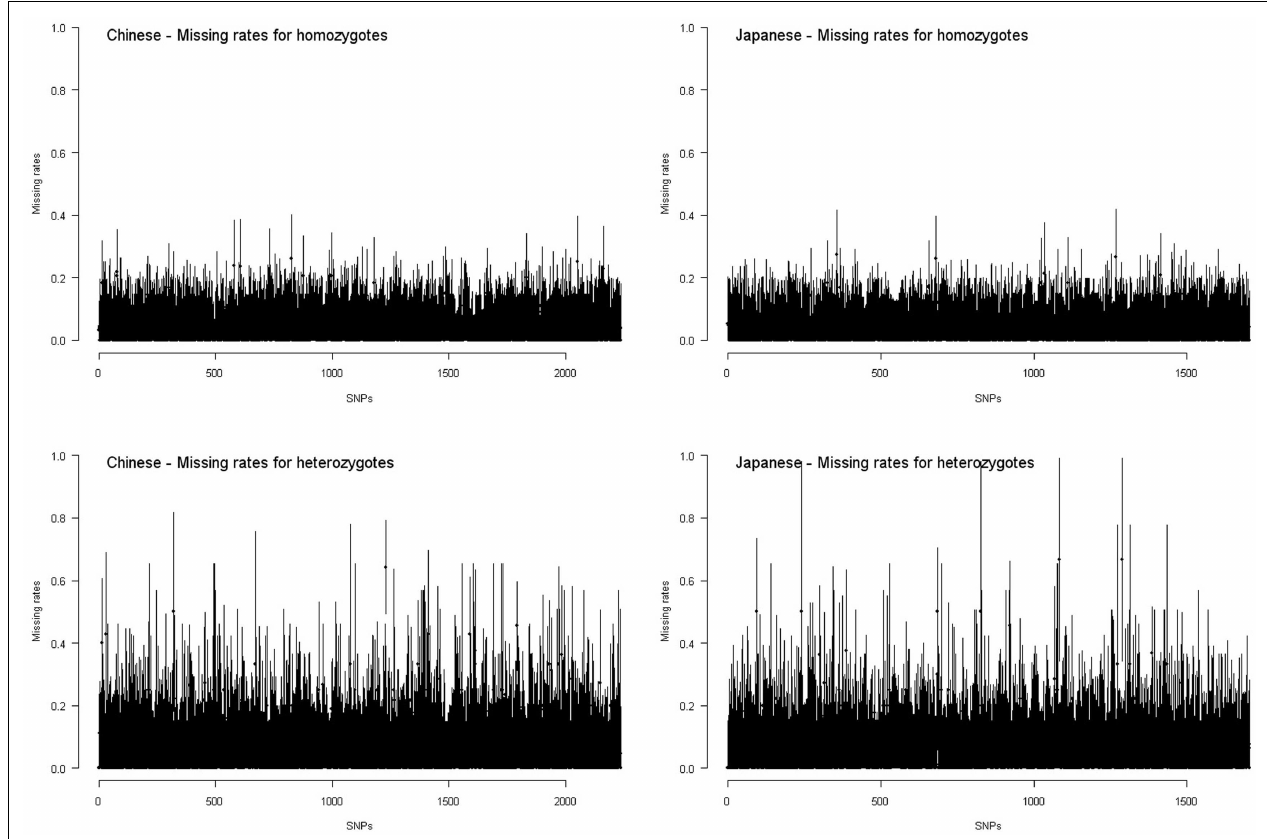
FIGURE 5 | Missing rates for homozygotes and heterozygotes in the HapMap Chinese and Japanese samples. Each interval presents the point estimate ± standard error of missing rate for homozygotes or for heterozygotes of a SNP.